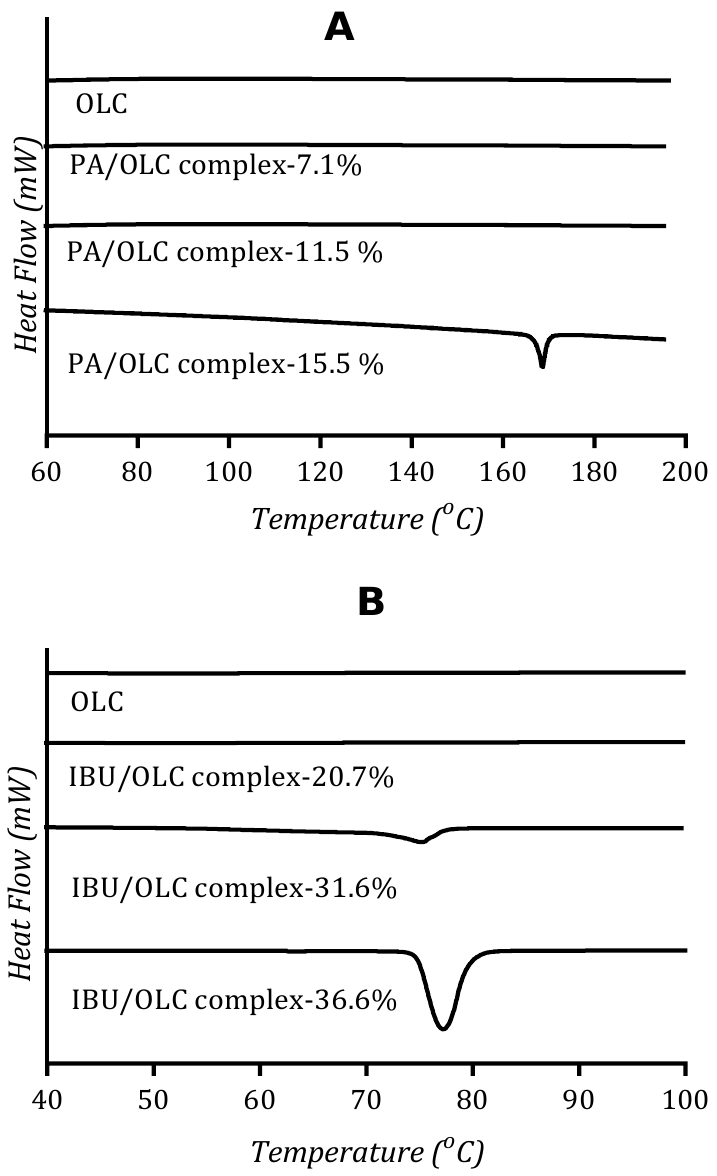
Figure 4. ( A ): DSC curves of carbon onion (OLC) and paracetamol loaded carbon onion (PA/OLC complex) with different drug loadings. ( B ): DSC curves of carbon onion (OLC) and ibuprofen-loaded carbon onion (IBU/OLC complex) with different drug loadings.